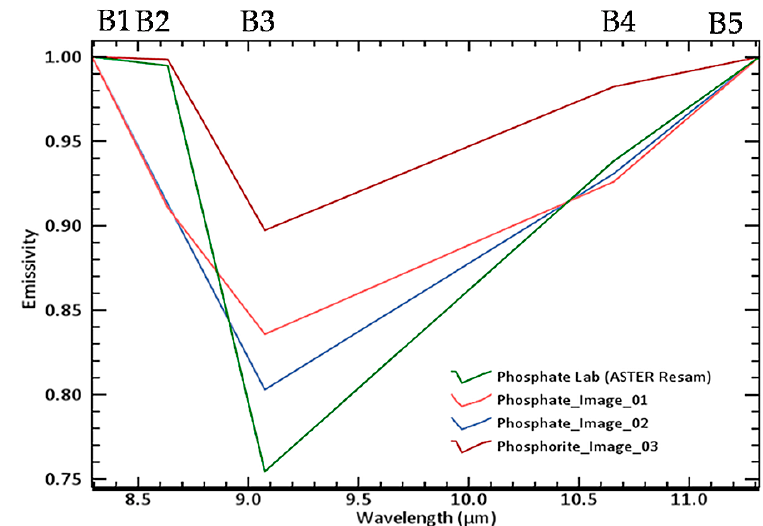
Figure 9. Comparison between the ASTER TIR band resampled mean high-grade phosphorite spectrum and with the few image spectra of phosphorite pixels. These pixels are the known exposures of phosphorite around the Jhamar Kotra mining area. Wavelength position of ASTER five TIR bands are also shown (B1 to B5).